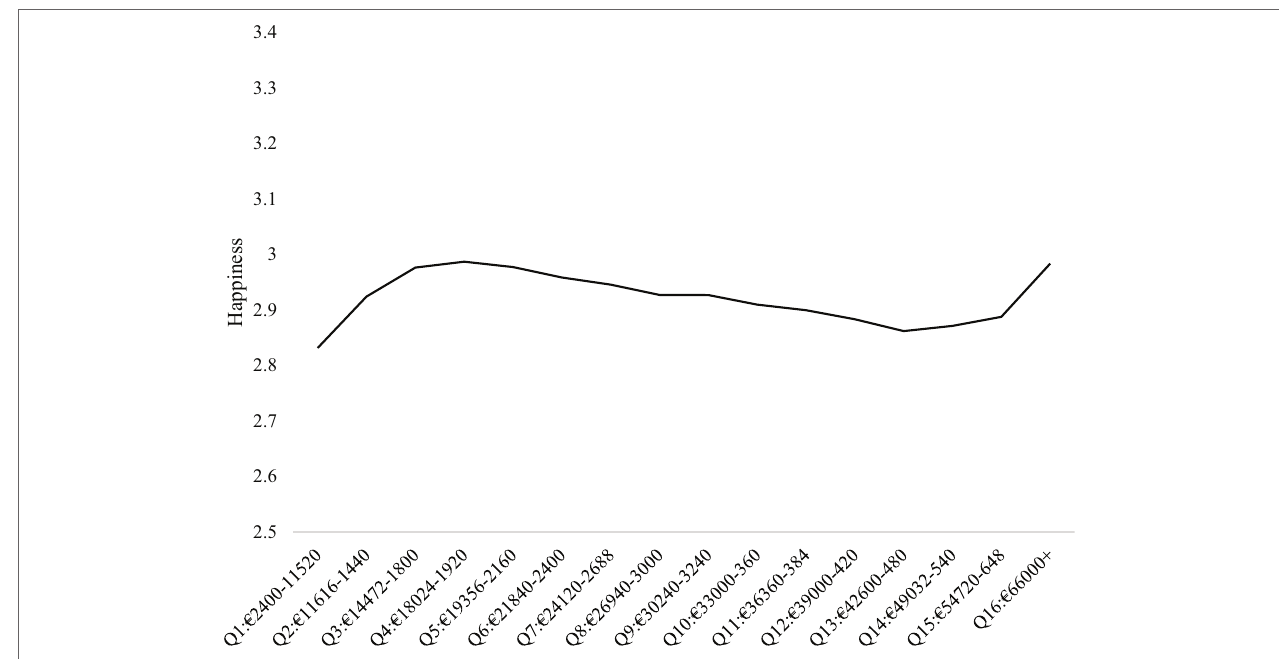
FIGURE 4 | Line graph of predicted values from lowess regressions explaining variance in happiness from income treated as a continuous variable in GSOEP DRMs at 16 quantiles of